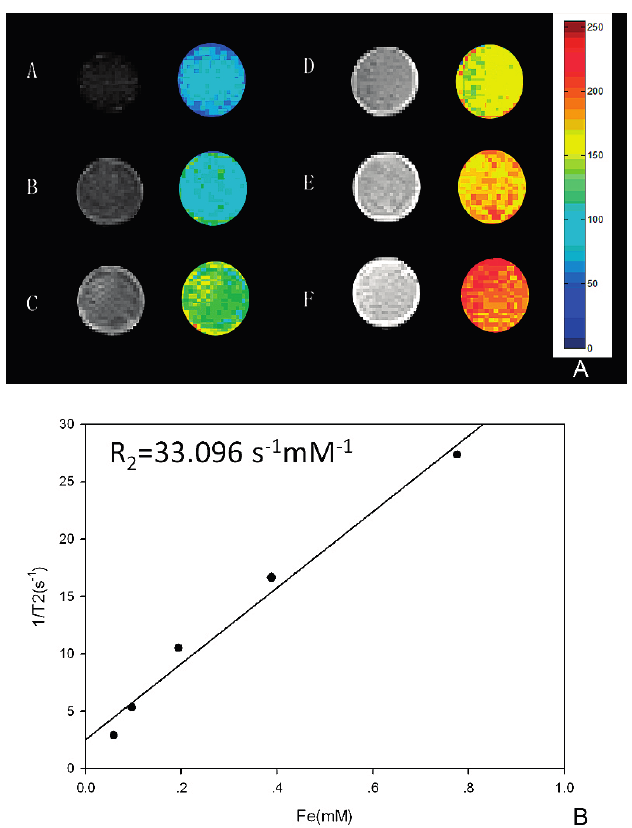
Figure 2. In vitro MRI of polypeptide-SPIONs. ( A ) In vitro MRI images of polypeptide-SPIONs: ( A – E ) polypeptide-SPIONs with Fe 3 O 4 concentration 0.060, 0.030, 0.015, 0.007, and 0.0045 mg/mL, respectively; F : de-ionized water; ( B ) The correlation between the Fe 3 O 4 concentration and